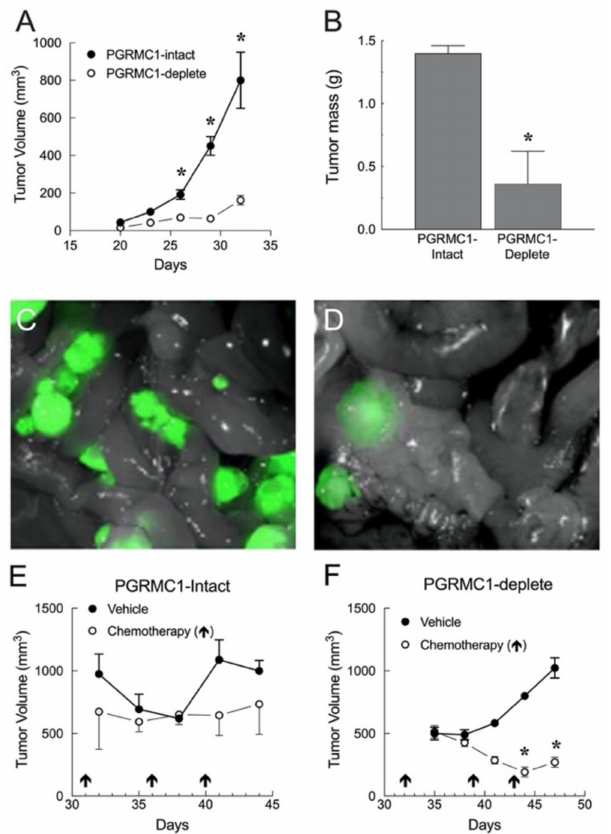
Figure 4. Comparison of xenograft tumor growth in PGRMC1-intact and PGRMC1-deplete en- dometrial tumor cells after a subcutaneous flank injection ( A ) or 6 weeks after an intraperitoneal injection ( B ). Images of intraperitoneal xenografts after injection with GFP-PGRMC1-intact ( C ) or GFP-PGRMC1-deplete ( D ) EV3 Ishikawa cells. Response of PGRMC1-intact ( E ) or PGRMC1-deplete ( F ) Ishikawa cell tumors treated with either vehicle (cremophor EL: ethanol) or paclitaxel and CARBO- platin injected as indicated by the arrows in plates ( E ) and ( F ). * indicates that a value is different from controls ( p < 0.05). Data redrawn from Figure 6A–D and Figure 7A,B from an article by Friel et al. [3] with permission from CCC